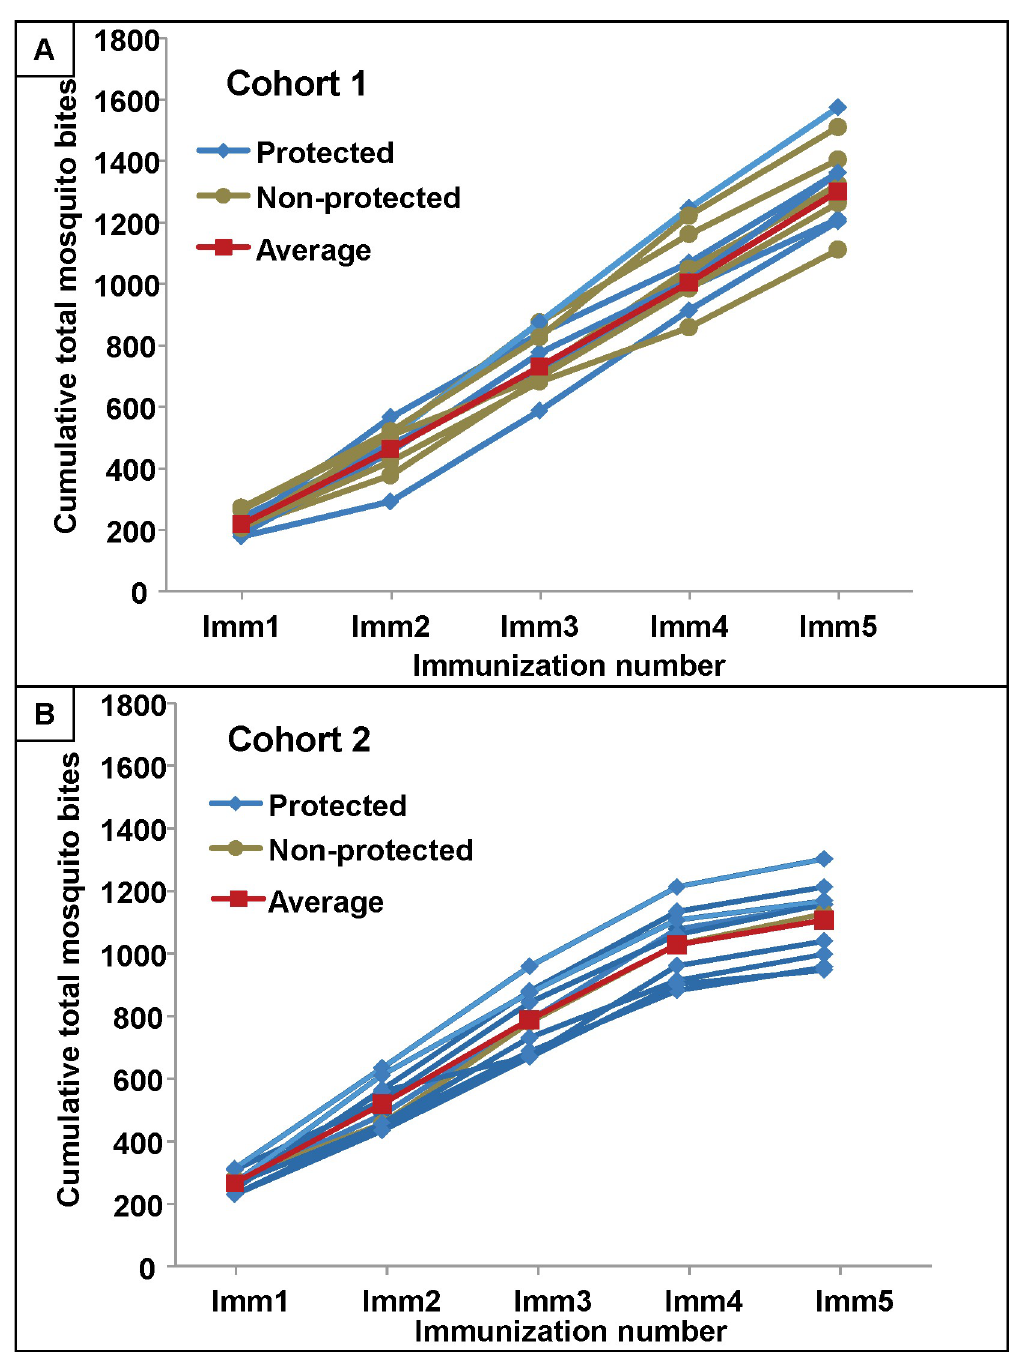
Fig 3. Cumulative numbers of bites in Cohort 1 and Cohort 2. The cumulative numbers of P . falciparum RAS-infected mosquitoes administered at immunizations 1–5 for each protected and non-protected subjects and the average cumulative total for all subjects. Panel A: Cohort 1. Panel B: Cohort